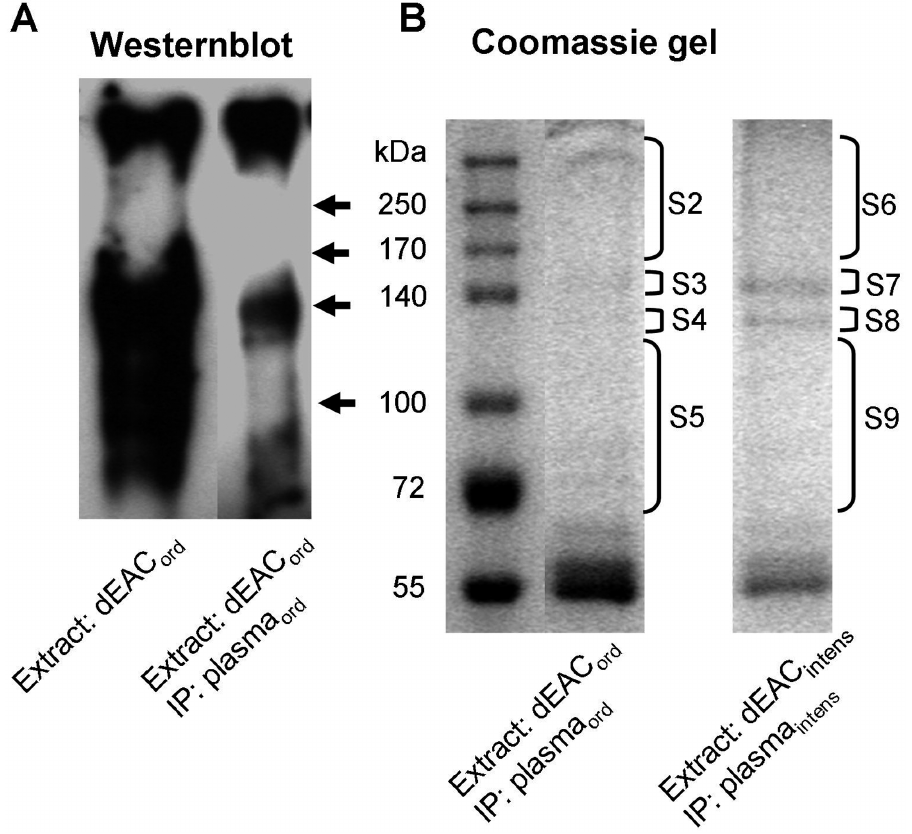
Figure 6. Immunoprecipitation of immunogenic proteins. 1 mg of dEAC ord and dEAC intens extracts were incubated with plasma from mice immunized with dEAC ord (plasma ord ) and dEAC intens (plasma intens ) overnight, immune complexes were precipitated with protein A agarose, separated by SDS-PAGE and coomassie-stained. Bands form the gel were excised as indicated by the brackets and submitted as samples S2–S9 to mass spectrometry.